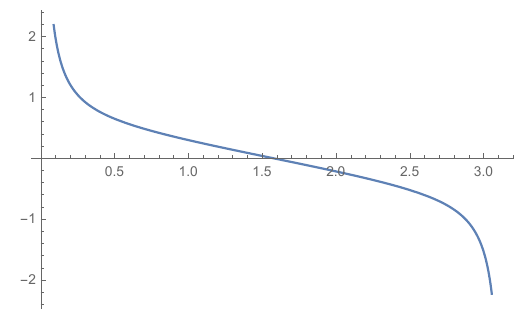
Figure 12 . The graph of the function g ( e i(cid:18) ) de(cid:12)ned by (4.6) at (cid:11) =